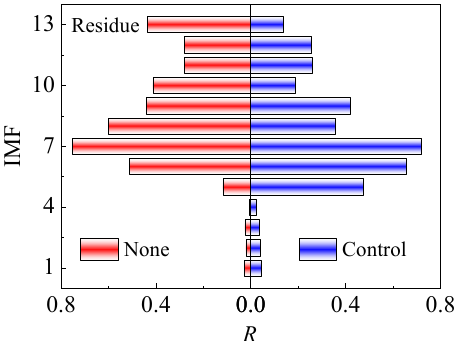
Figure 10. Correlation coefficient of each IMF and original signal.